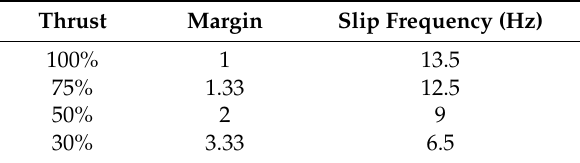
Figure 4. Ratio of normal force and thrust force according to slip frequency. Table 2. Normal force margin ratio by slip frequency at each